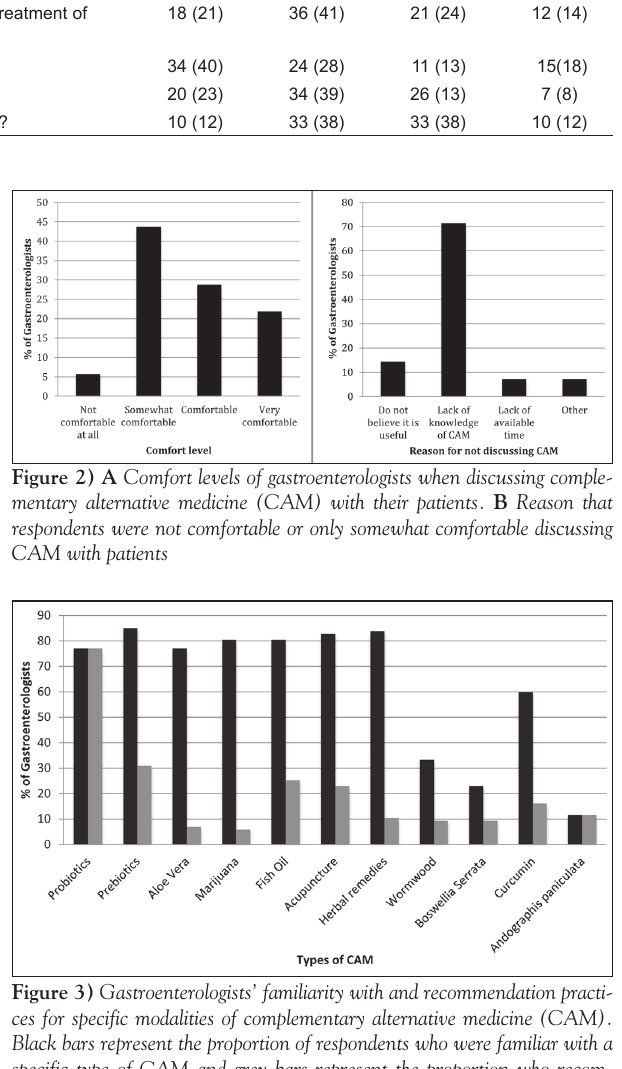
TABLE 2 Gastroenterologist perceptions and practices regarding complementary alternative medicine (CAM) What percentage of your patients has mentioned the use of CAM as a part of their treatment of inflammatory bowel disease?